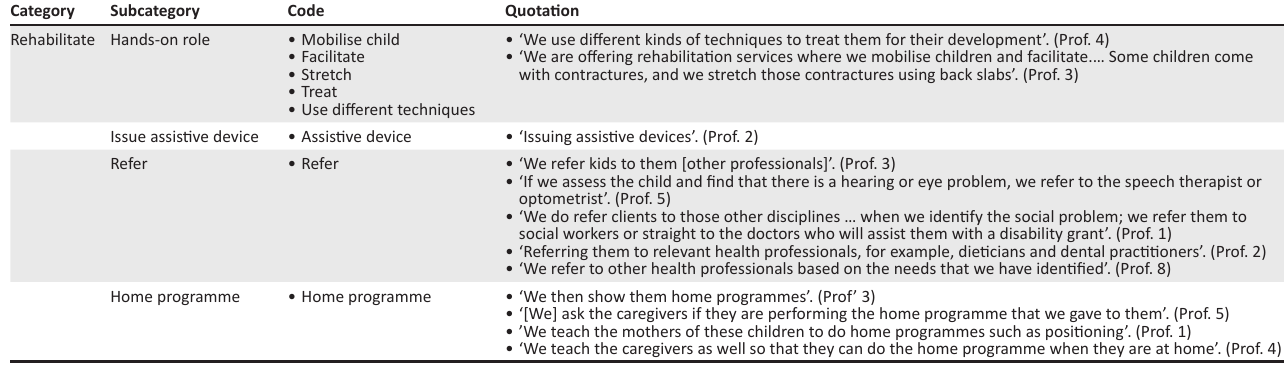
TABLE 5: Role of rehabilitation professionals: Rehabilitate. Category